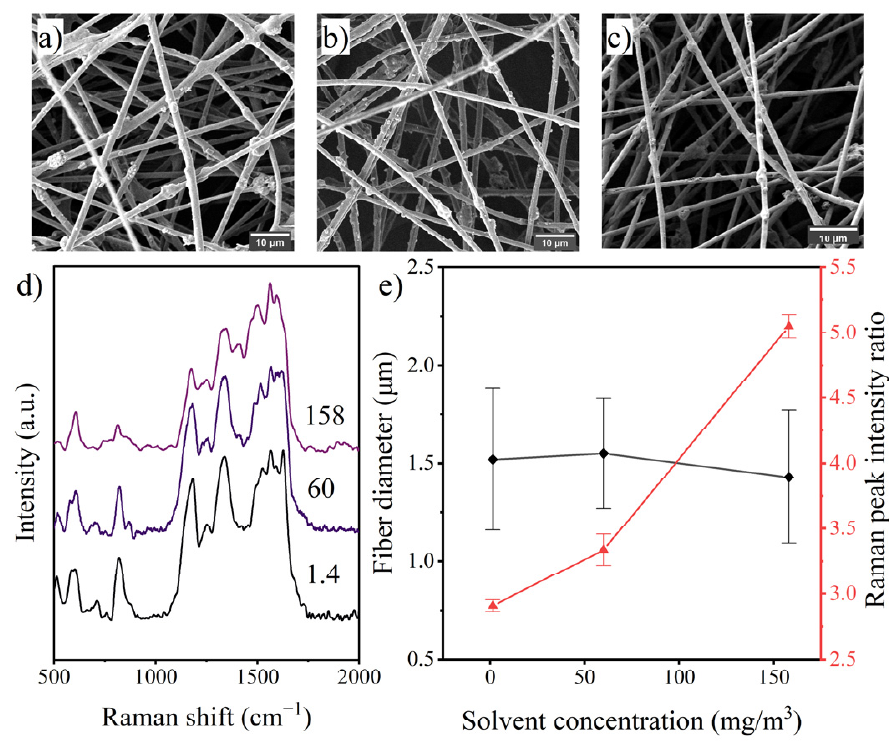
Figure 8. SEM images of fibers prepared with solvent concentrations of ( a ) 1.4 mg/m 3 , ( b ) 60 mg/m 3 , ( c ) 158 mg/m 3 ; ( d ) Raman spectra of the fibers and ( e ) effects of solvent concentration on fiber diameter and surface PANI occupancy.